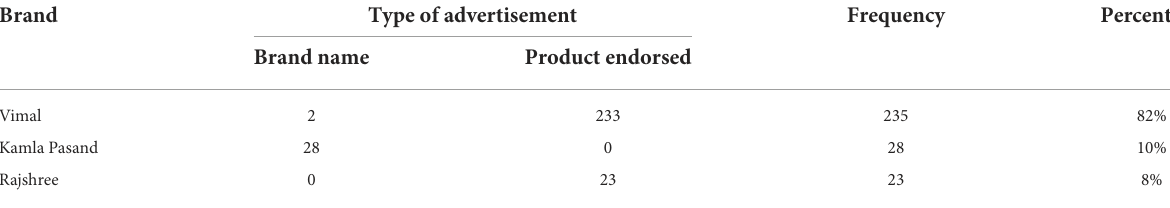
TABLE 2 List of the companies documented in the study utilizing the strategy of surrogate advertisement.